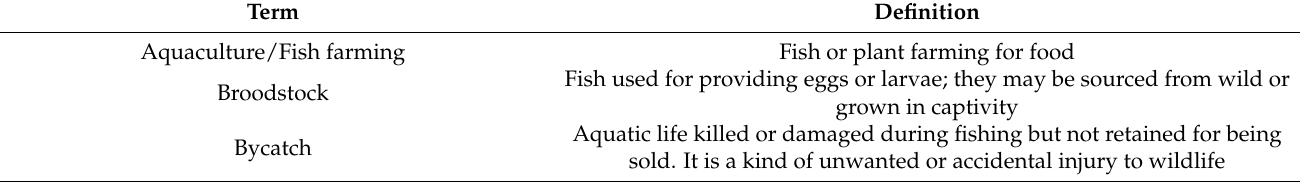
Table 1. A glossary for a better understanding of food waste and loss in fishery. The definitions and the concepts have been found and modified from Goodfish